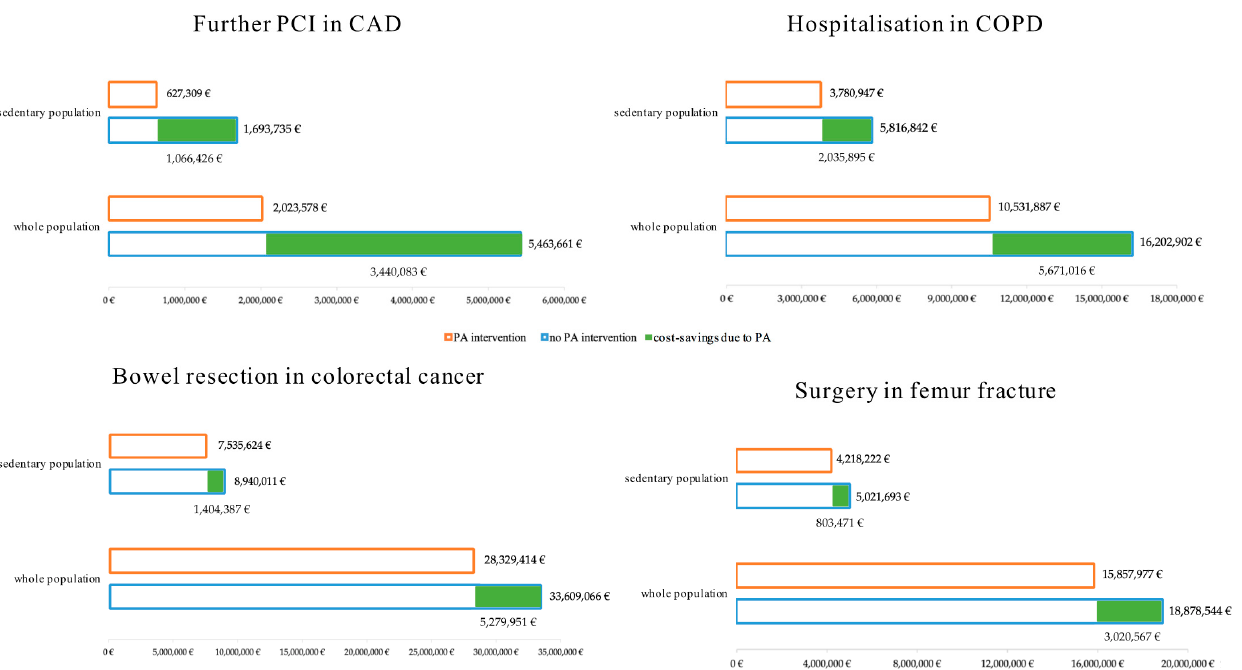
Figure 2. Healthcare costs and potential cost ‐ savings in different chronic diseases. CAD: coronary artery disease, PCI: percutaneous coronary interventions, COPD: chronic obstructive pulmonary disease, PA: physical activity.